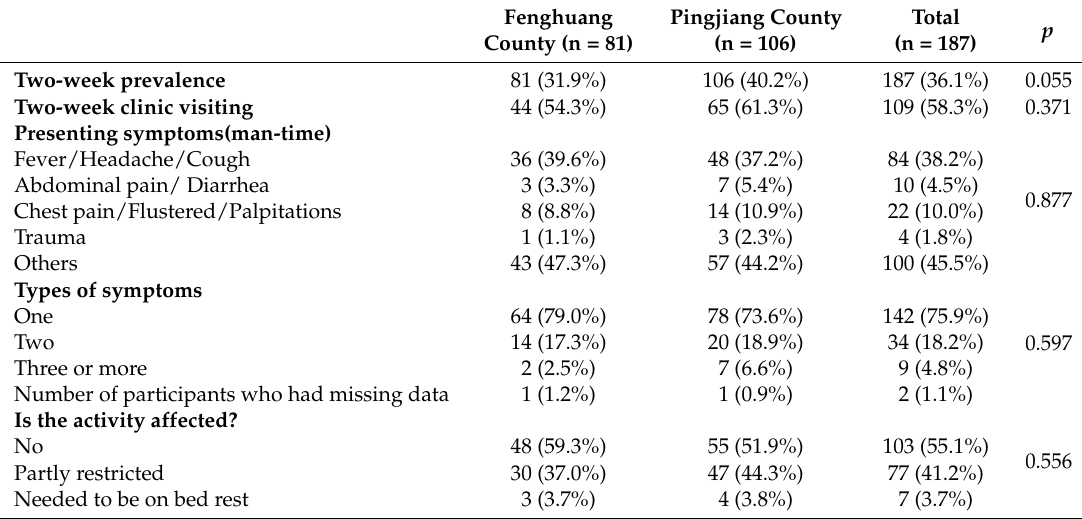
Table 2. Health situation and health service needs among CLBC (n, %).